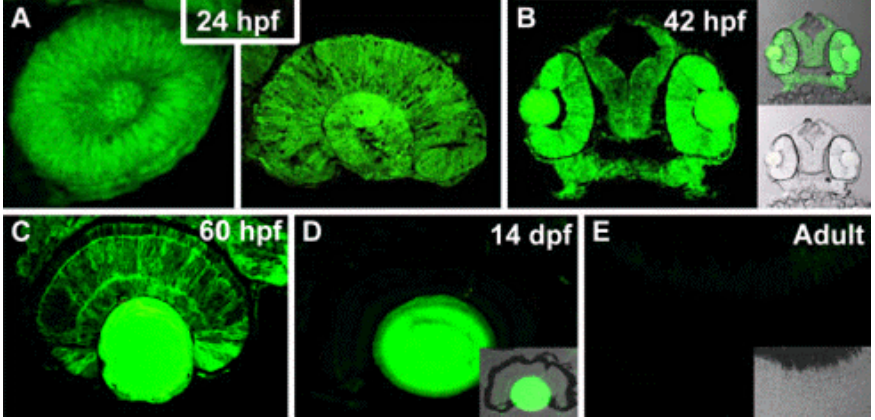
FIGURE 2. Expression of Tg( ef1- α :EGFP ) nt during retinal development. Expression of the ef1- α :EGFP transgene is progressively silenced during retinal development. (A) Sagittal and frontal sections (left and right, respectively) taken at 24 hpf, shows ef1- α :EGFP expression in the developing lens and every neuroepithelial cell of the immature retina. (B) Frontal section shows ubiquitous expression of the ef1- α :EGFP transgene at 42 hpf. A brightfield image and a fluorescent/brightfield merged image are shown to the right. (C) Starting at 60 hpf, frontal sections differentially express the ef1- α :EGFP transgene in the retina, with continued strong expression in the lens. (D) By 4 dpf, expression of the ef1- α :EGFP transgene is primarily restricted to the lens and a few cells scattered throughout the retina. (E) By 14 dpf, ef1- α :EGFP transgene expression is completely silenced in the retina, but is still strong in the lens. A fluorescent/brightfield merge image is shown in the inset.